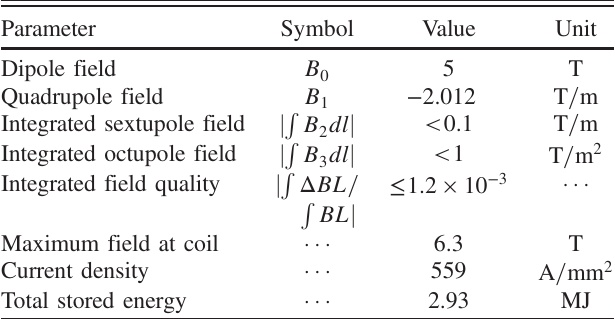
TABLE V. Magnetic parameters of the superconducting 90° combined-function